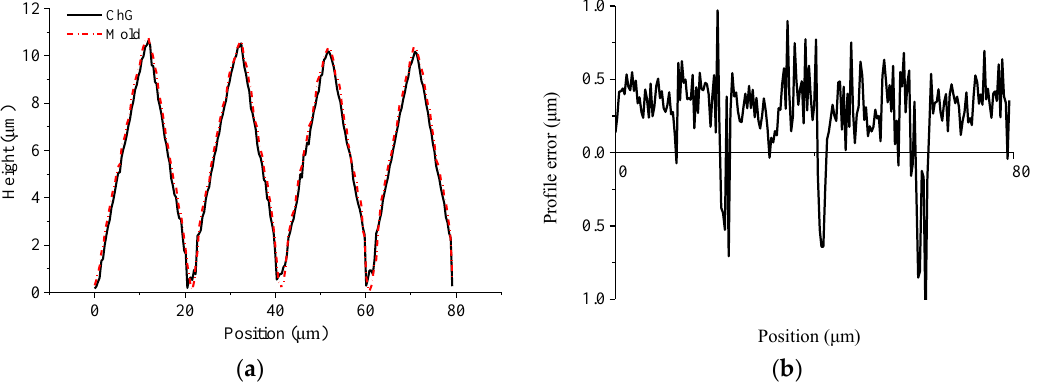
Figure 27. Microscope images of microstructures on ( a ) mold surface and ( b ) ChG surface.